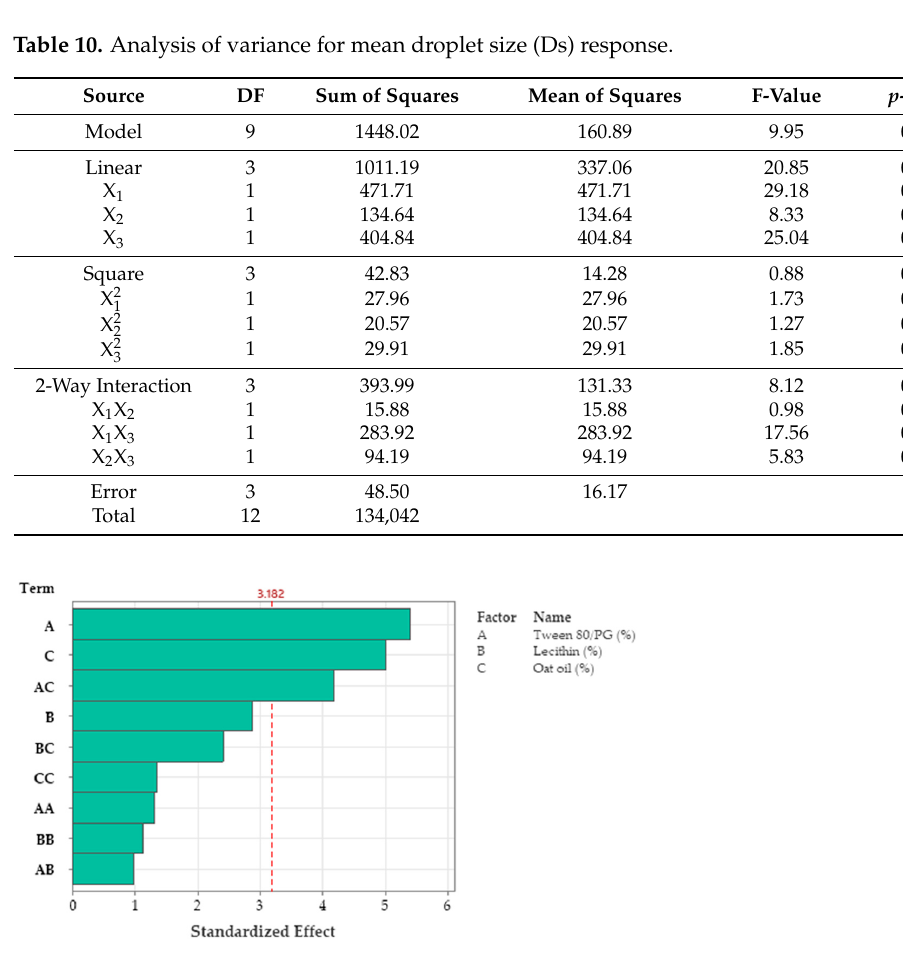
Figure 16. Pareto Chart of standardized effects for Ds response, emphasizing main factors implied